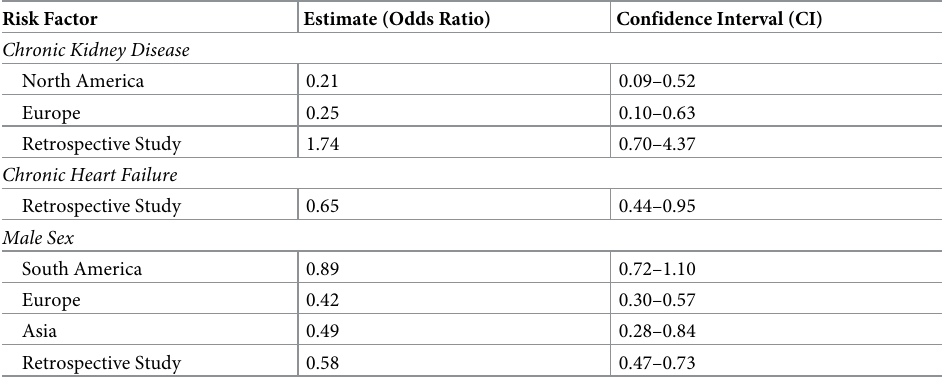
Table 2. Meta-regression results for COVID-19 related mortality and hospitalization studies.